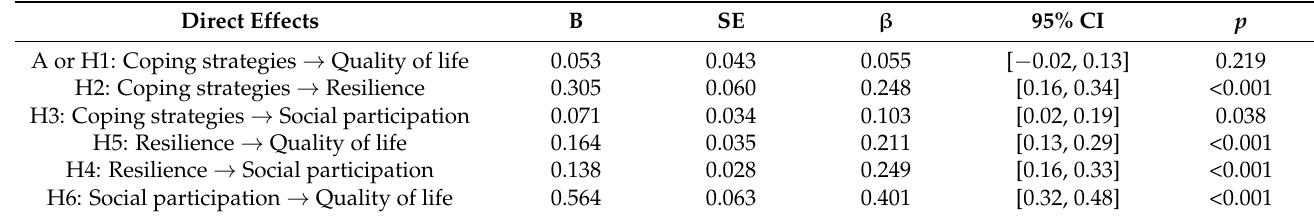
Figure 2. Path analytical model of the inter-relationship between the study variables. Table 3. Direct effects of the predictor variables and mediators.